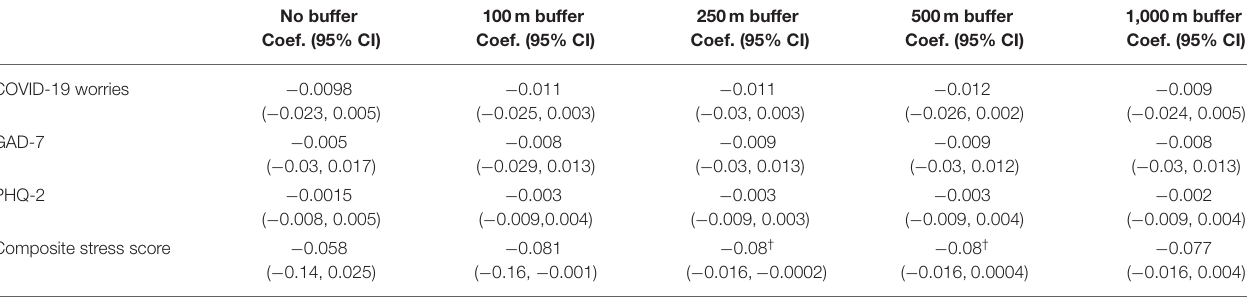
TABLE A1 | Preliminary Greenspace buffer analysis to determine optimal buffer size.